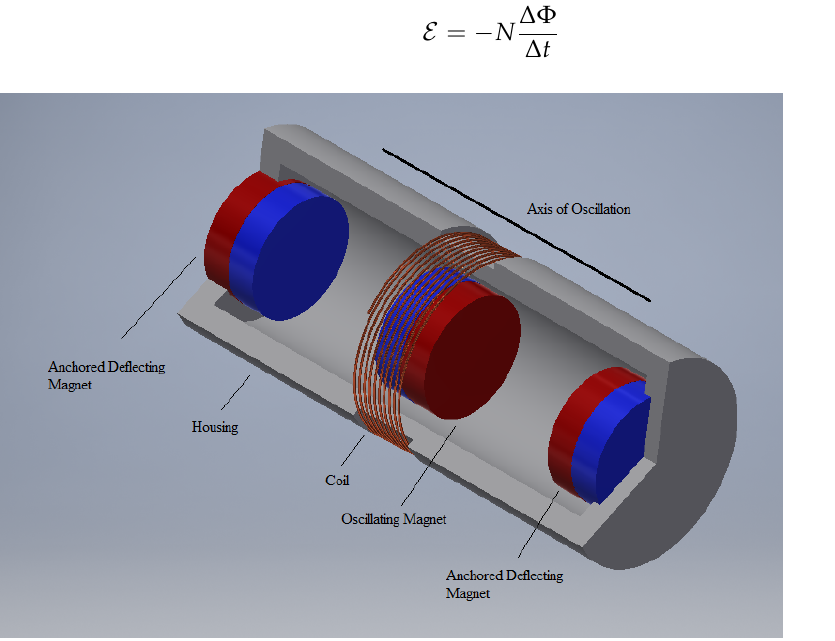
Figure 1. Example of a common small-scale electromagnetic energy harvester, which typically uses one degree of freedom along the axis of oscillation as a method of harvesting energy using